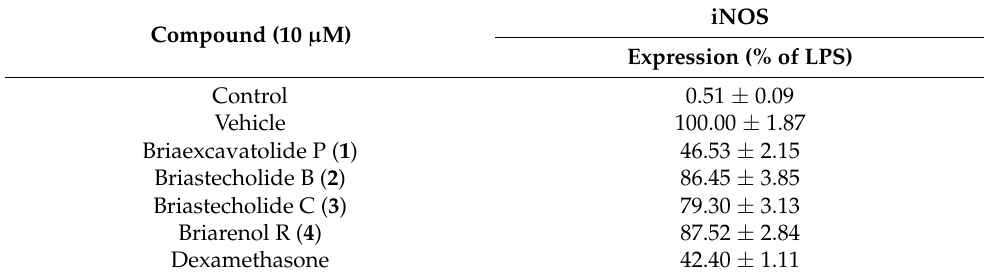
Table 2. Effects of briaranes 1 – 4 on LPS-induced pro-inflammatory iNOS protein expression in macrophages.